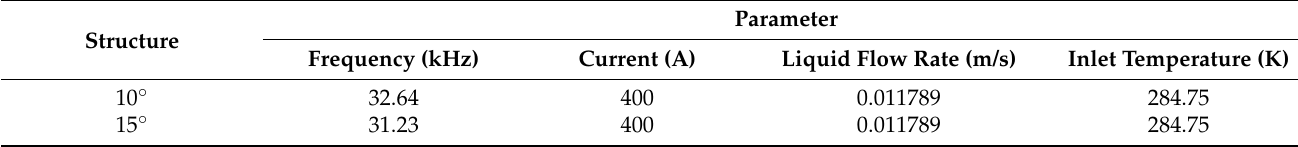
Table 4. Simulation Boundary Condition Parameters of High Heating Power